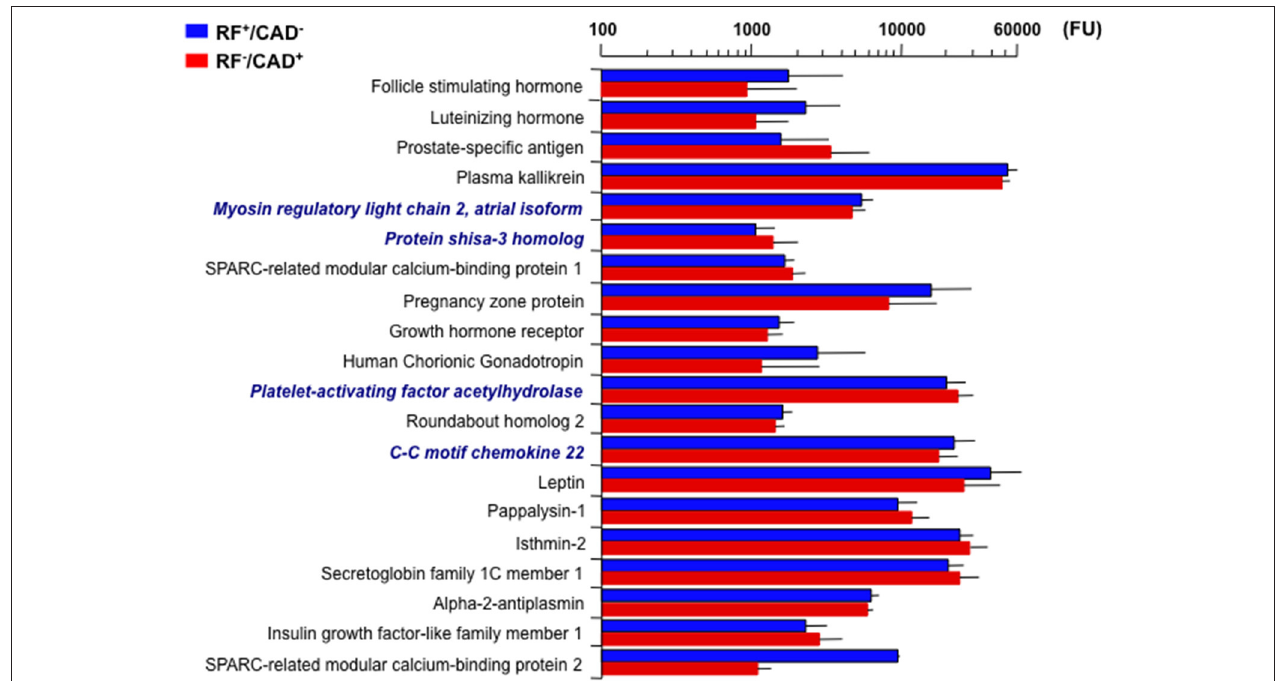
FIGURE 1 | Twenty top plasma signals associated with the outlier groups (CAD + /RF − and CAD − /RF + ). Signals are in fluorescence units (FU). Bars are mean ± standard deviation. Bold italics indicate the four proteins that remained significantly different between the two groups after adjusting for gender and age. CAD, coronary artery disease; RF, risk